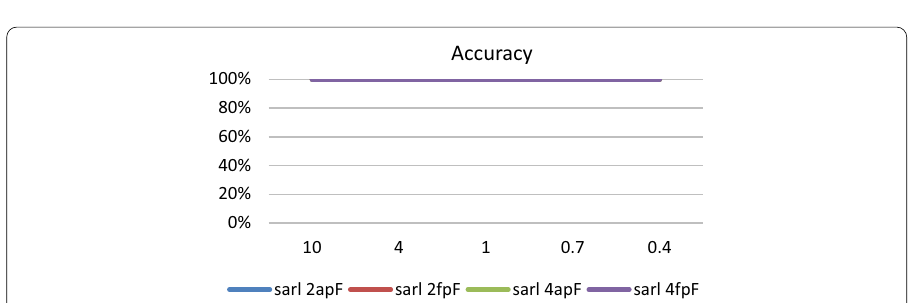
Fig. 9 Accuracy of SARL heuristic on T10I4D100K